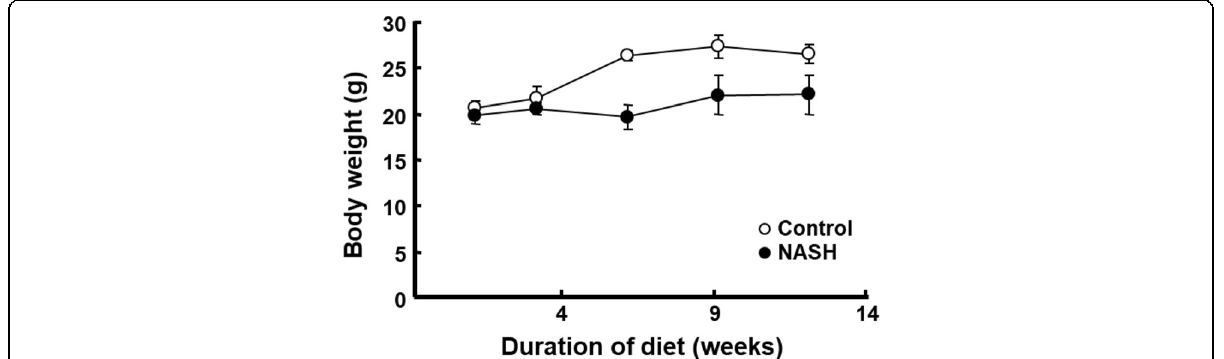
Fig. 5 Body weight of mice fed a choline-deficient, L -amino acid defined, high-fat diet (CDAHFD) or a standard diet for 1 to 12 weeks. Data are presented as the mean ± standard deviation of 4 – 6 mice per group except for mice fed CDAHFD for 12 weeks, where N = 3